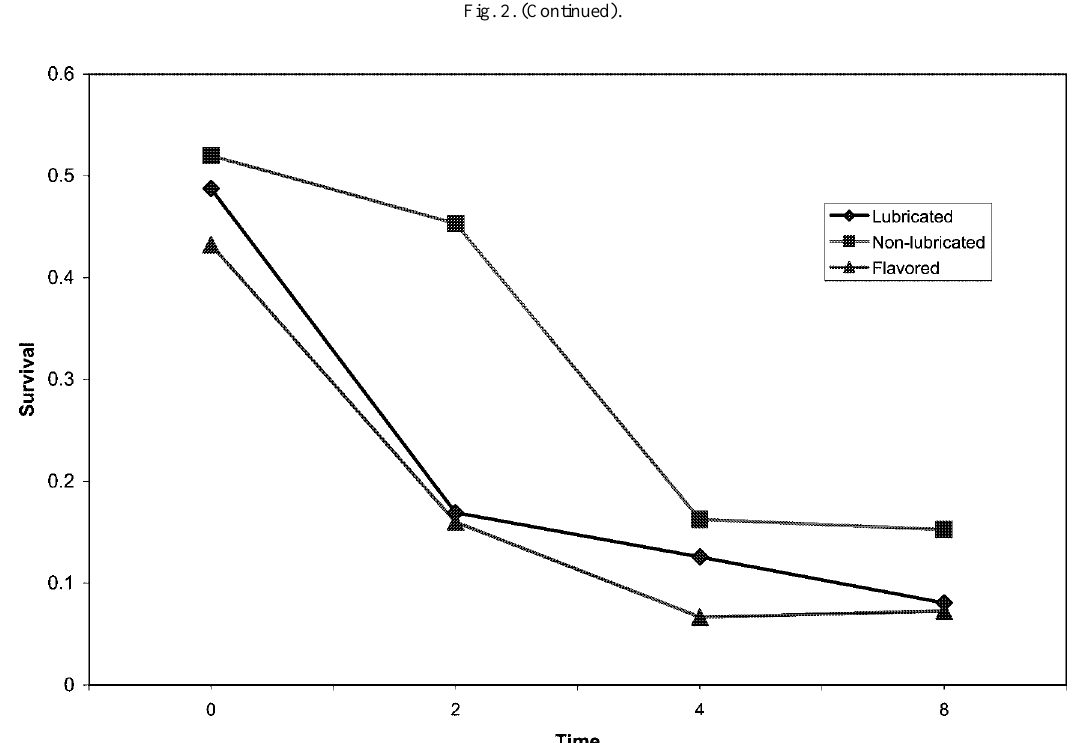
Fig. 3. LSH (T) means of survival by type versus time (Crystal Violet